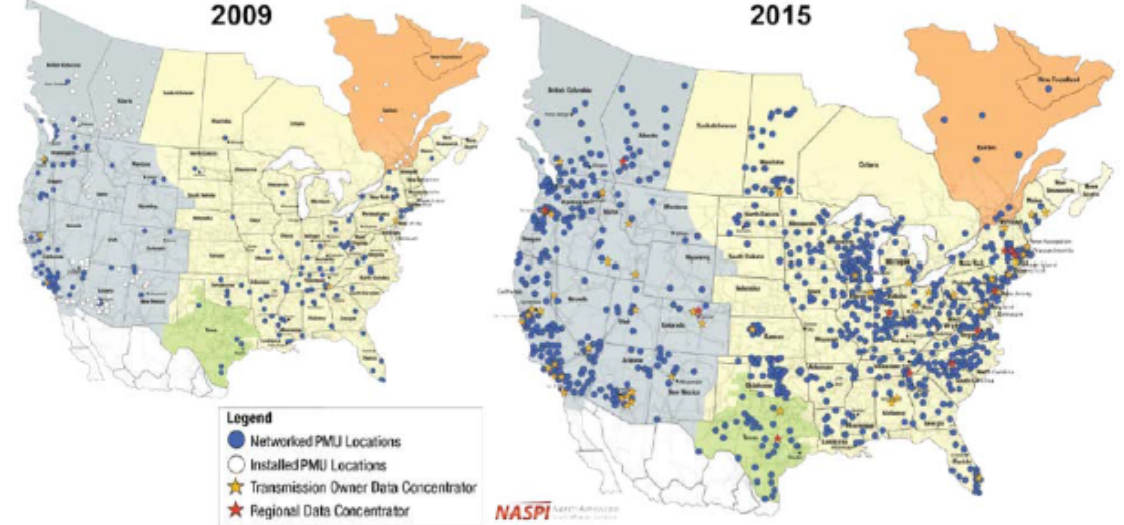
Figure 2. Phasormeasurement units, technologies that enable superfast network management across large interconnected systems, are being deployed to improve grid operation